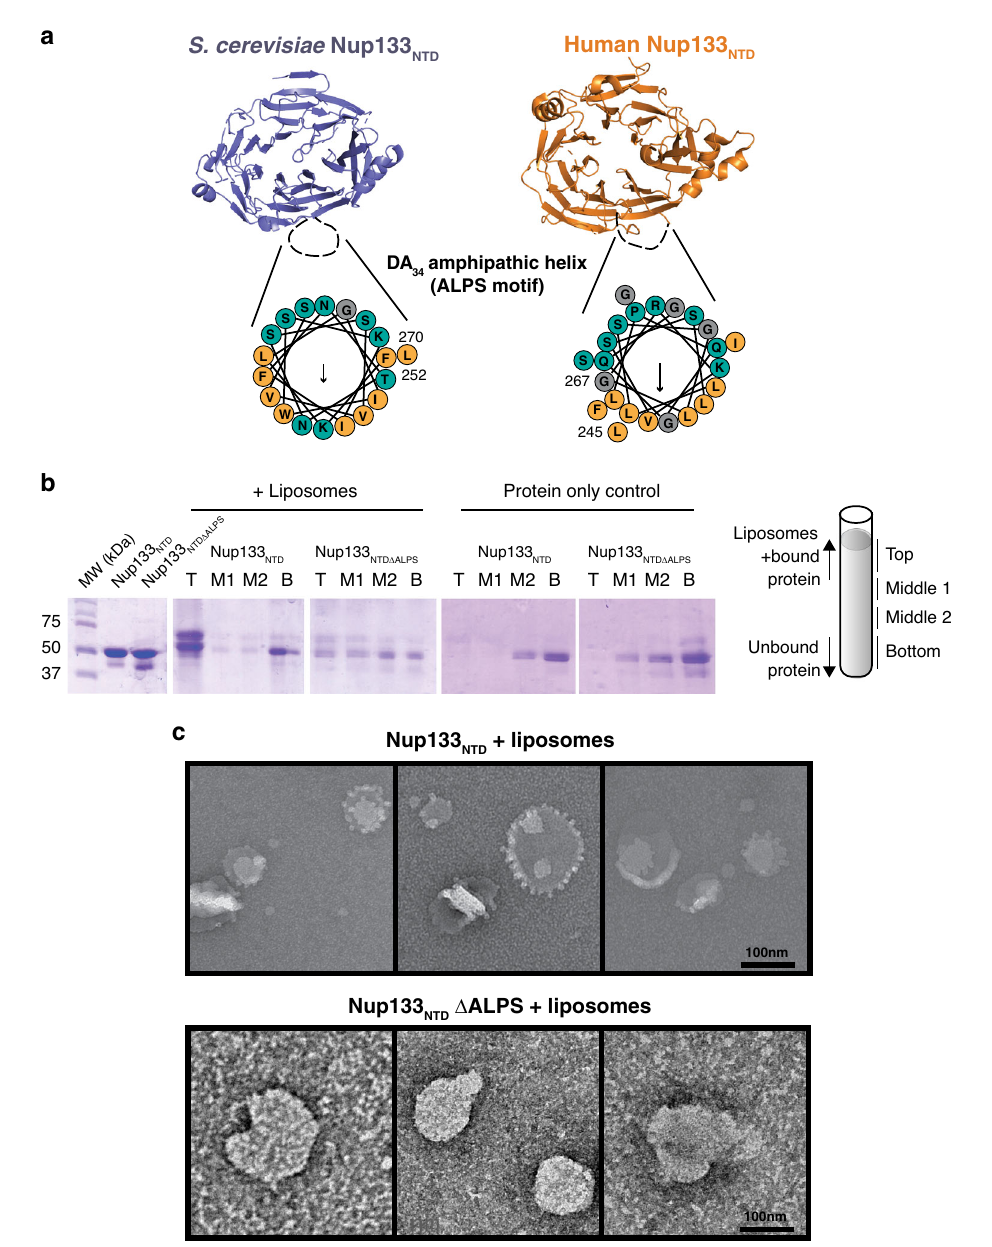
Fig. 5 Nup133 NTD has an ALPS motif. a Structures of scNup133 NTD (purple) and hsNup133 NTD (orange). The missing DA 34 loop in the structures are indicated by a black dotted line. Helical wheel diagram for each loop is shown with polar residues (teal), nonpolar (orange), and glycine (gray) colored. Arrow indicates predicted hydrophobic face and length of arrow scales with strength of the hydrophobic moment. b Liposome fl oatation assay with Nup133 NTD . Panels show Coomassie stained SDS-PAGE fractions isolated from the gradients. A cartoon of fractions is shown on the right. c Negative stain electron microscopy images of liposomes preincubated with Nup133 NTD (upper) and Nup133 NTD Δ ALPS (lower). Scale bar at the bottom left of each panel. Panels are representative images taken from two independent of conformational differences (Fig. 6). Both models have the same dimensions overall, but superpositioning the two models using Nup145C, the most rigid part of the Y complex, reveals hinge points in both, the short arms and the stalk of the Y. In the short arm of Nup85-Seh1, we notice signi fi cant motion around the trunk-to-tail transition of Nup85. Additionally, Nup120 is bent more outward from the hub in our previous model. The stalk has multiple points of fl exibility. The Nup84 tail is positioned about ~4 nm away from its previous position, with the majority of the movement occurring around the hinge at the trunk-tail interface.